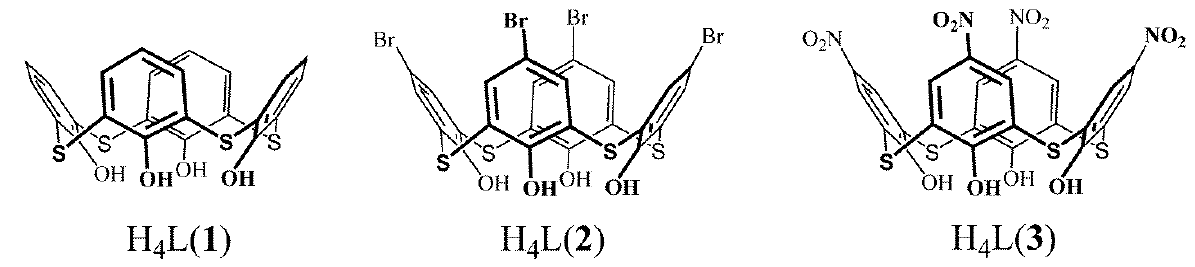
Figure 1. Thiacalix[4]arenes H 4 L( 1 – 3 ) studied in this work.